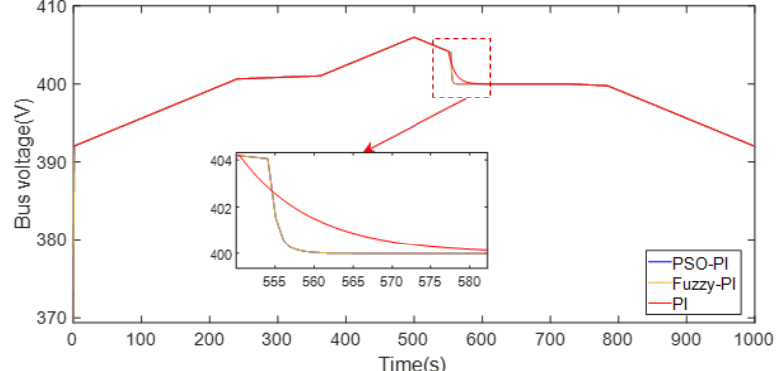
Figure 28. Bus voltage in Example 3 without AA-CAES.